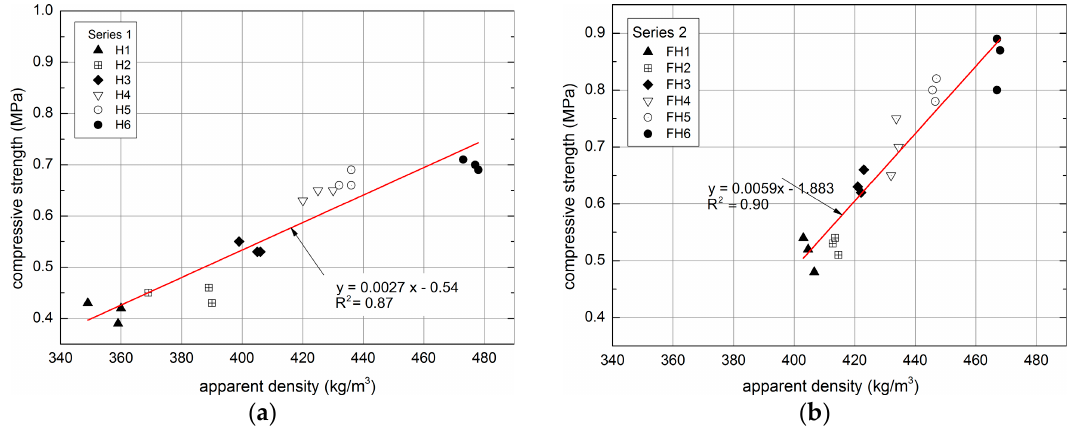
Figure 17. Relationship between apparent density and compressive strength of tested composites: ( a ) Series 1, ( b ) Series 2. ( a ) Series 1, ( b ) Series